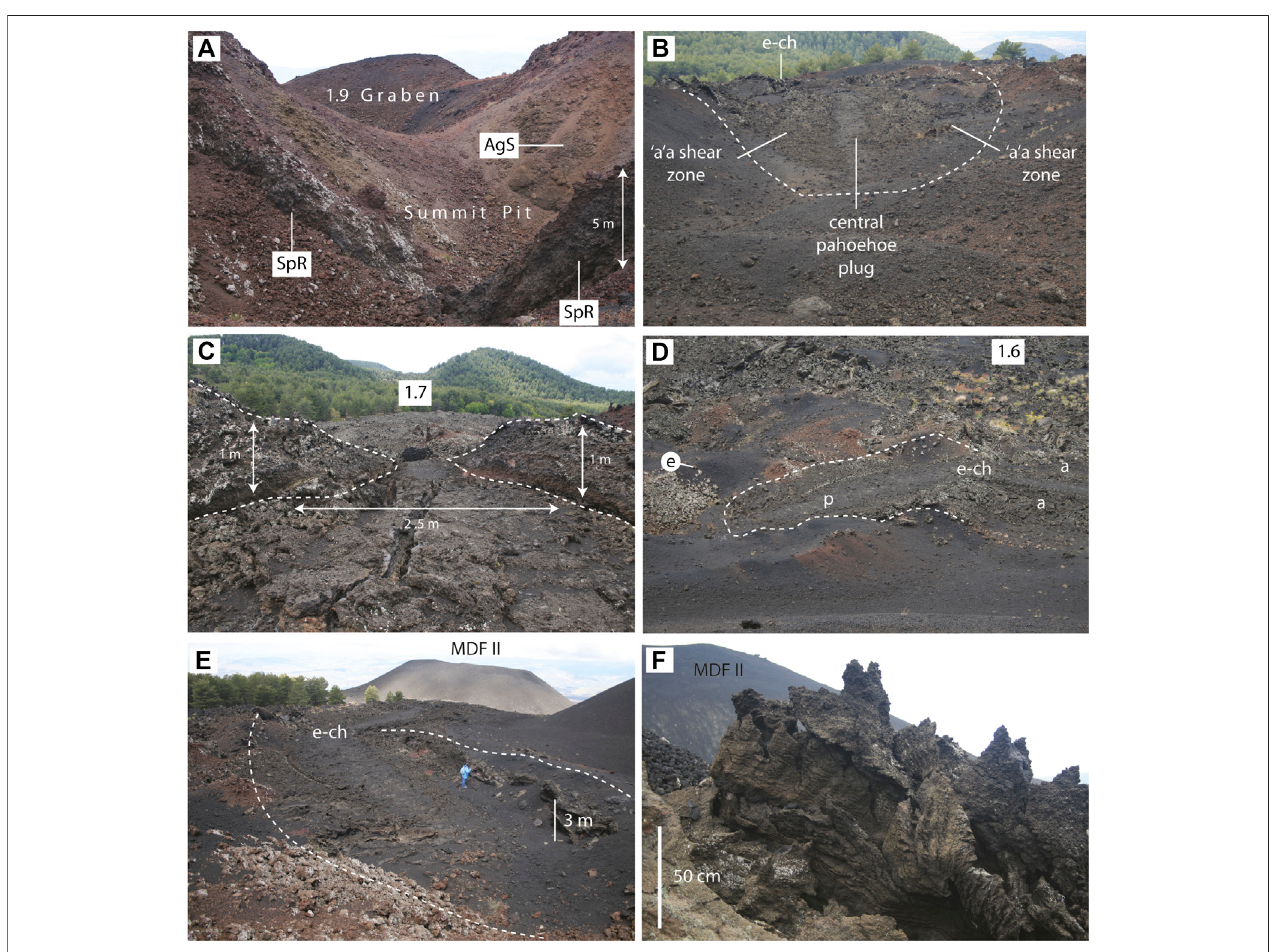
FIGURE5|(A) ViewfromtheSErimofthesummitofMDFIIlookingNWintothesummitpitshowingspatterramparts (SpR)overlainbyagglutinated spatter(AgS). (B) View of the 1.7 “ lava lake ” from the NE rim of the 1.7 vent structure showing fi nal fl ow out of the lake and into the exit channel (e-ch). Main “ lake ” area is outlined with dashedlineandisaround20 macross. (C) ViewSEdowntheexitchannelfromthe1.7 “ lake ” withlevee ’ soutlinedwithdashedline.Channelcontainsundrained,in fl ated p (cid:1) ahoehoe with in fl ation cleft running down-channel. Proximal portion of lava unit 1.7 in background as labeled. (D) View of the 1.8 “ lava lake ” from the S rim of the MDF I showing fi nal fl ow out of the lake and into the exit channel (e-ch) where “ a ” denotes ’ a ’ a shear zones and “ p ” the central plug of p (cid:1) ahoehoe. Main “ lake ” area is outlinedwithdashedlineandisaround6 monthelongaxis,andtheunderlyinglavaunit(1.6)isinthebackground. (E) ViewNWtowardsMDFIIandacrossthe1.8 “ lake ” (outlined with dashed line) showing exit channel (e-ch) and proximal portion of lava unit 1.8. (F) Toothpaste lava in the 1.10 vent.